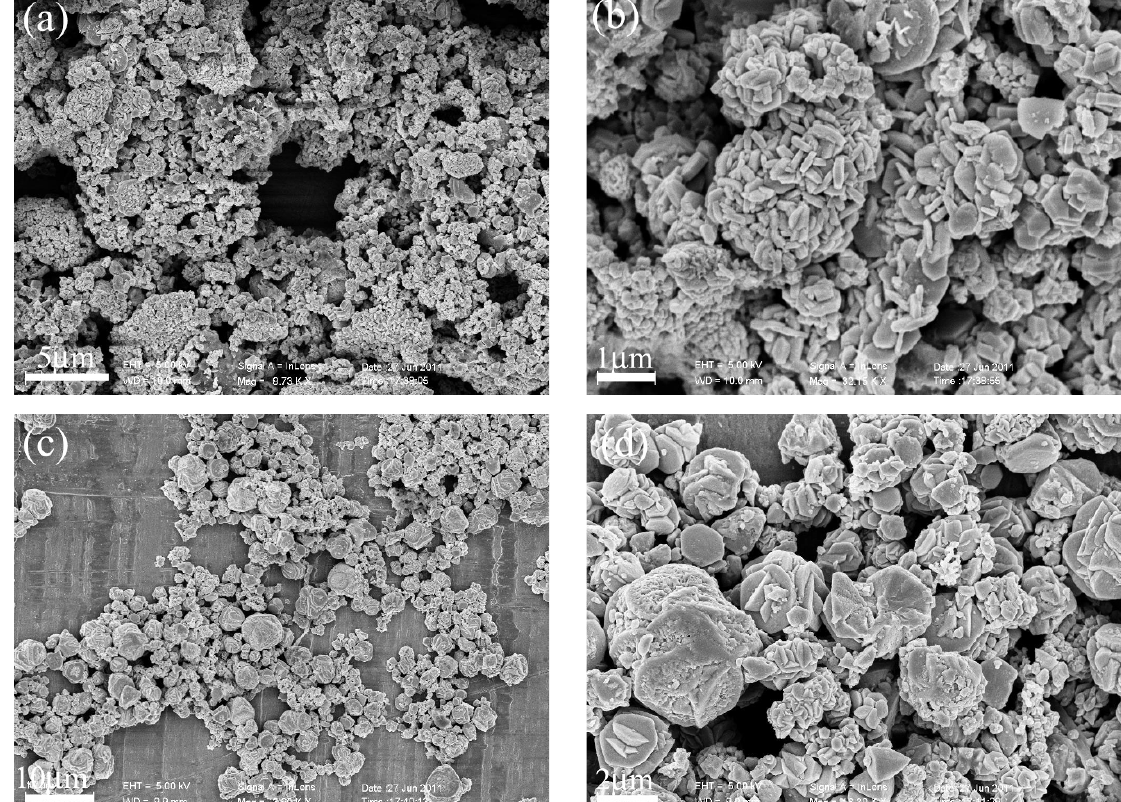
Figure 4. (a) and (b) Different magnification FESEM images of products using CdSO FESEM images of products using lauryl mercaptan as the sulphur